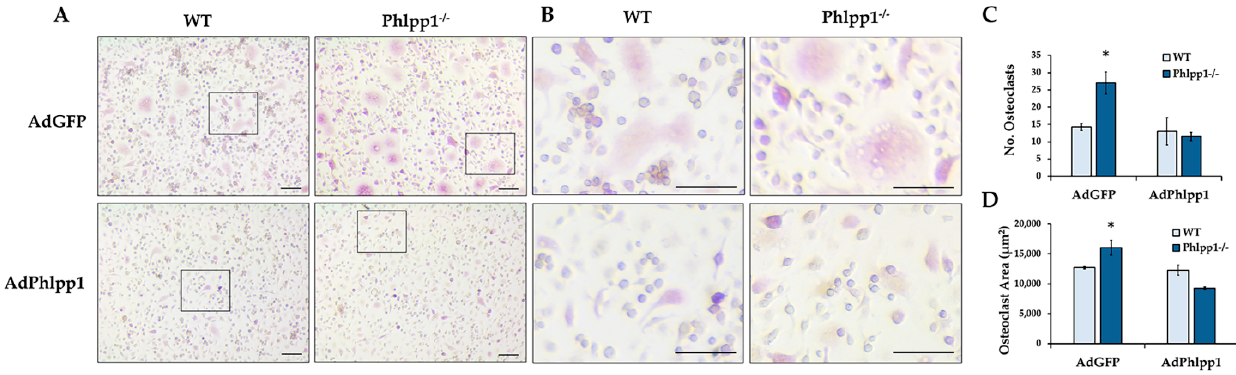
Figure 4. Phlpp1 Represses ex vivo Osteoclastogenesis. Osteoclasts were generated from bone marrow macrophages collected from 6–8-week-old Phlpp1 − / − females or their sex-matched WT controls. Cultures were infected with each indicated adenovirus (MOI = 10) on day 0 and samples were collected on day 4. ( A , B ) TRAP staining of Phlpp1 − / − or WT cultures. Insets in panel ( A ) denote locations of higher power images shown in ( B ). ( C ) Number of osteoclasts and ( D ) average osteoclast area per field were determined, *: p < 0.05 as compared to WT, AdGFP samples. Scale bars are 100